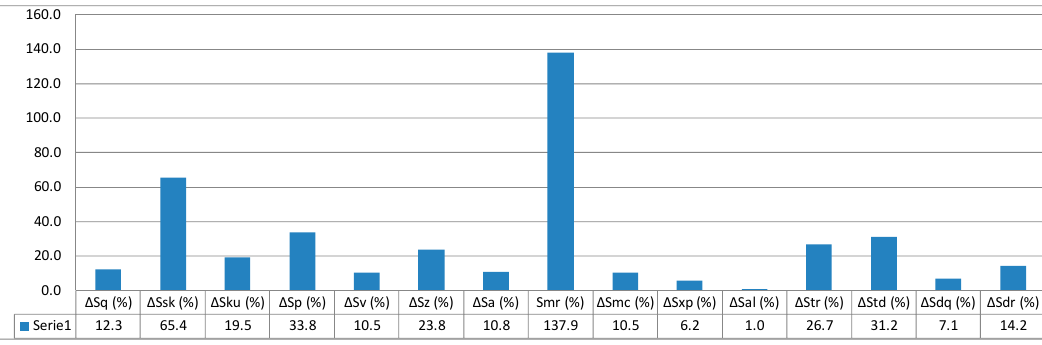
Figure 11. Relative values of surface parameters for printing orientation 45°.